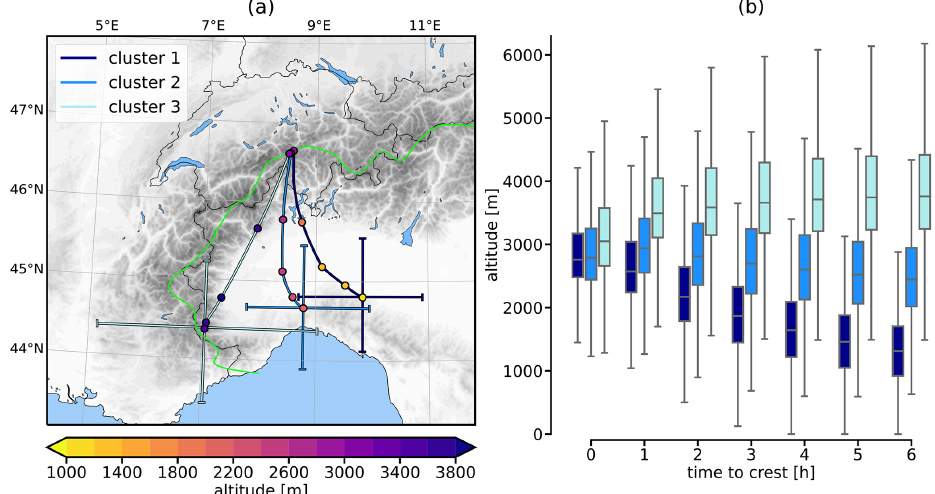
Figure 7. (a) Mean pathways of the three trajectory clusters (bold lines in shades of blue) and variability in the position 12h prior to arrival at the crest (bars ranging from minus to plus 1 standard deviation in the longitudinal and latitudinal direction, respectively). Dots mark every 3h and are coloured according to the mean altitude of the clusters at the respective time step. Note that for the data points earlier than 6h with respect to the crest, the mean is calculated by excluding trajectories that left the domain in the meantime. (b) Height distribution of the three trajectory clusters starting from 6h prior to the crest in hourly intervals. The boxplot whiskers range from 1.5 times the interquartile range below the first quartile to 1.5 times above the third quartile. Outliers are not shown.